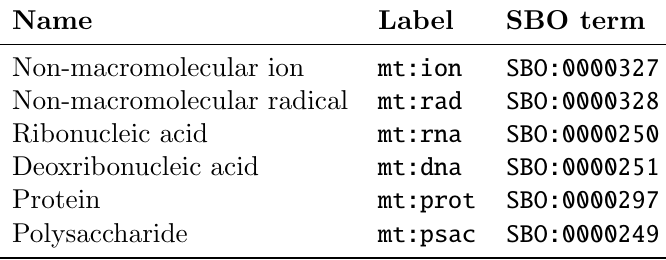
Table 2.2: A sample of values from the material types controlled vocabulary (Section 2.2.1).